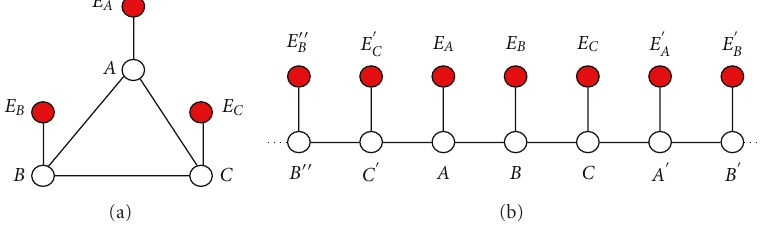
Figure 2: (a) A simple loopy network, (b) Corresponding unwrapped network for the first 3 iterations.